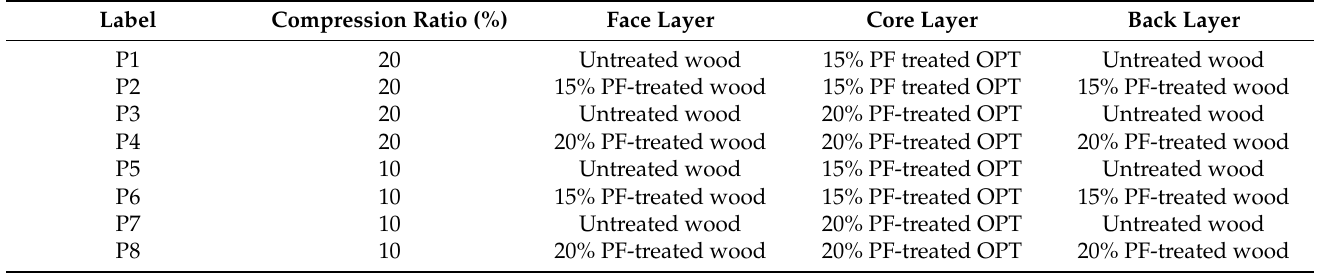
Figure 1. Product description for laminated compreg composite products. Table 2. Description of the product of laminated compreg composites produced in this work.